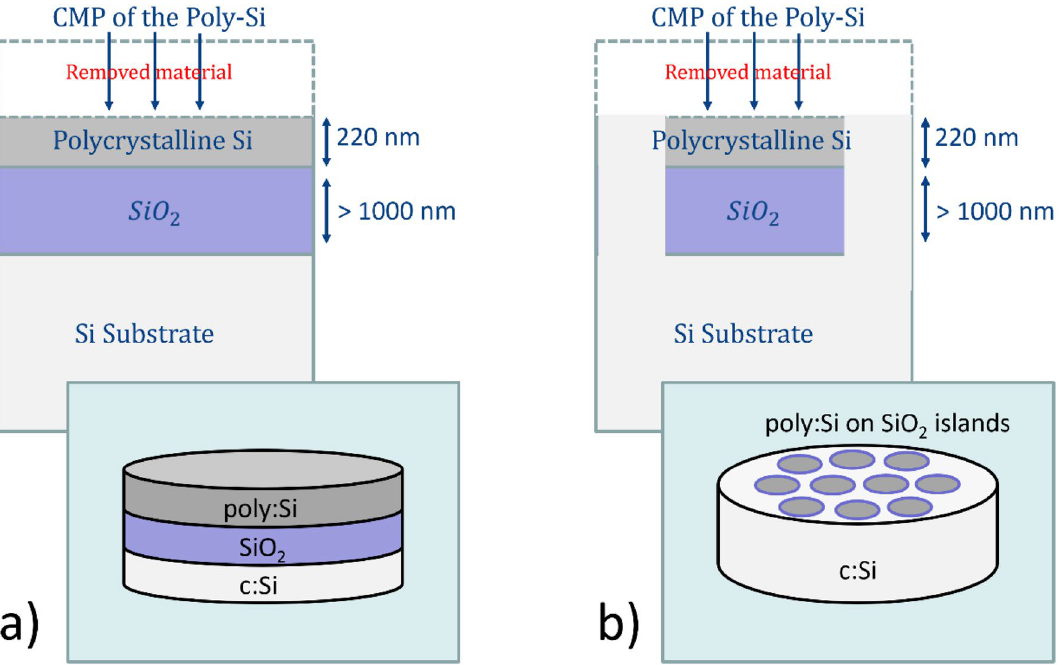
Figure 2. Schematics of the poly:Si substrates in the two configurations: ( a ) thermally annealed poly:Si deposited onto PECVD SiO 2 for the CMP process optimization and ( b ) poly:Si on SiO 2 islands nested into a bulk silicon wafer for the fabrication of poly:Si optical